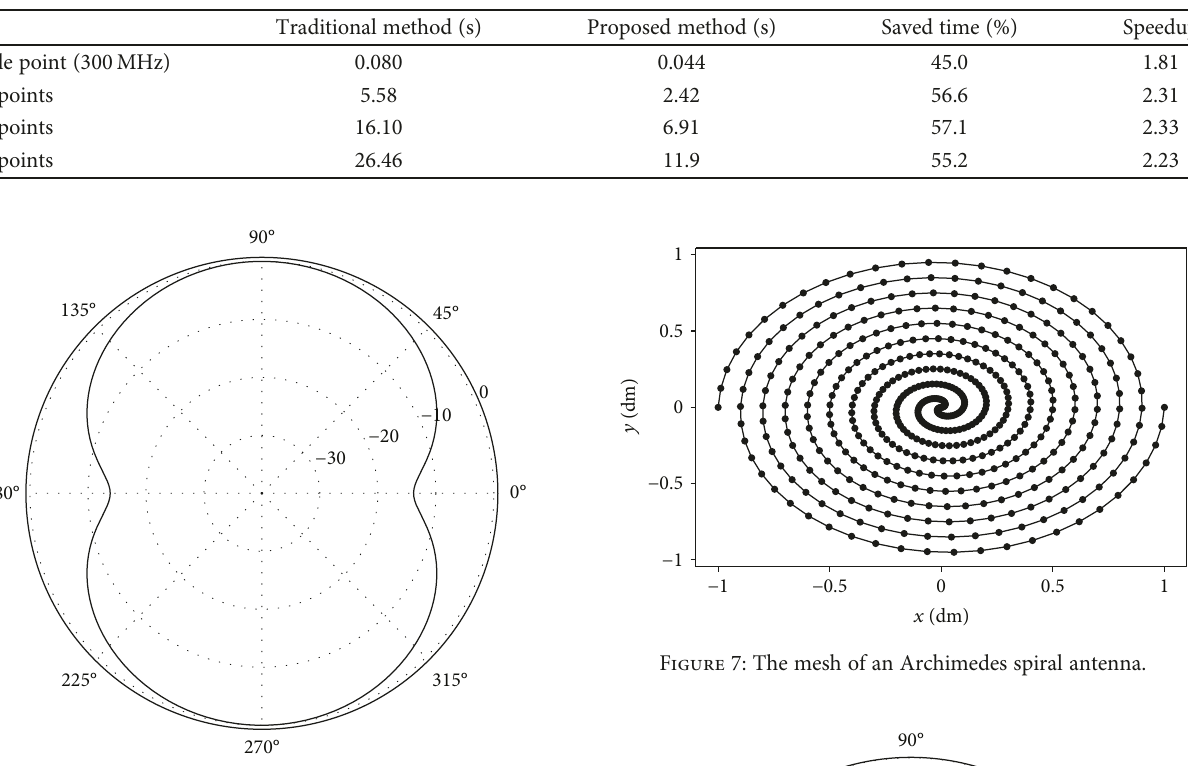
Table 3: CPU time of the traditional method and the proposed method.